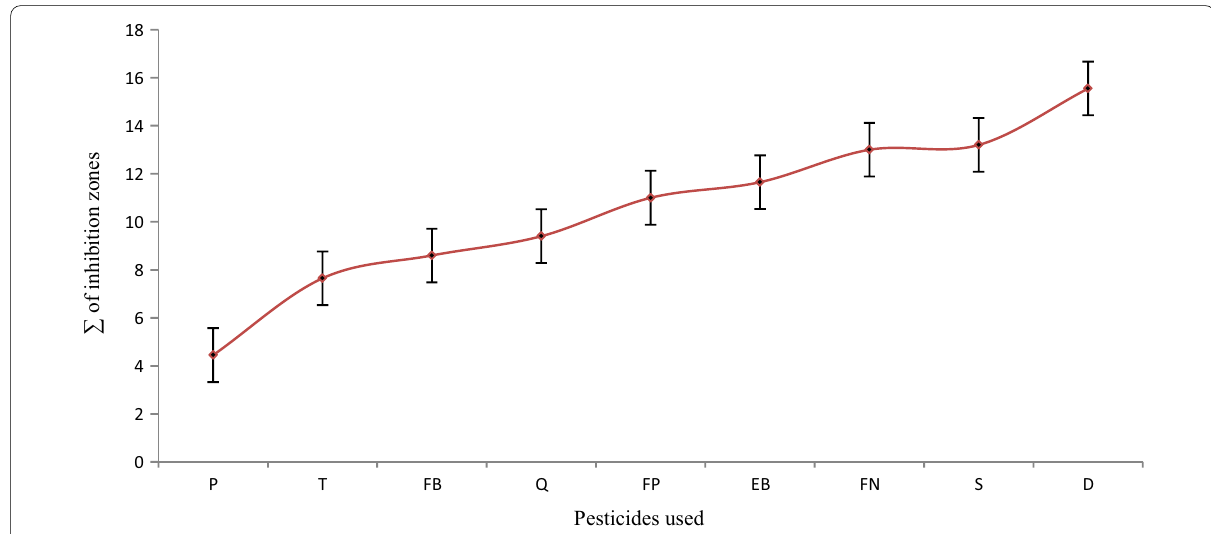
Fig. 3 Tolerance pattern (mean of replications) of PSMC isolates against some common pesticides used in tea